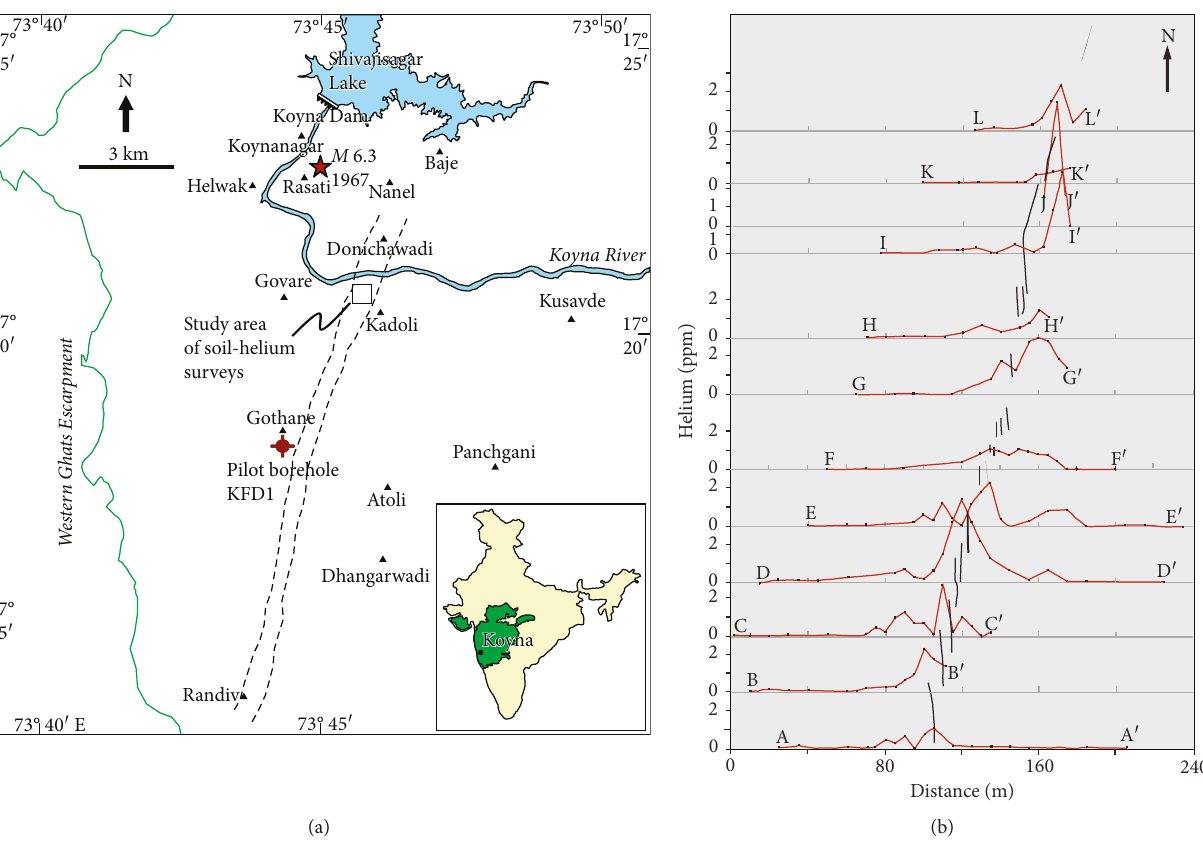
Figure 1: (a) Map of the Koyna region showing the locations of the 1967 M 6.3 Koyna earthquake (red star) and the pilot borehole KFD1. The trace of the Donichawadi fi ssure zone (dashed lines), formed during 1967 earthquake [31, 40], and the study area (square) where the soil- helium surveys were conducted during 1996-1997 are also shown. Inset shows the location of Koyna within the Deccan Traps province (shaded green) on the outline map of India. (b) Map showing the coincidence of the helium anomalies established by soil-helium measurements along 12 traverses (AA ′ , BB ′ , … , LL ′ ) with coseismic en echelon fi ssures (thick lines) from the 1967 earthquake (Gupta et al. [41])